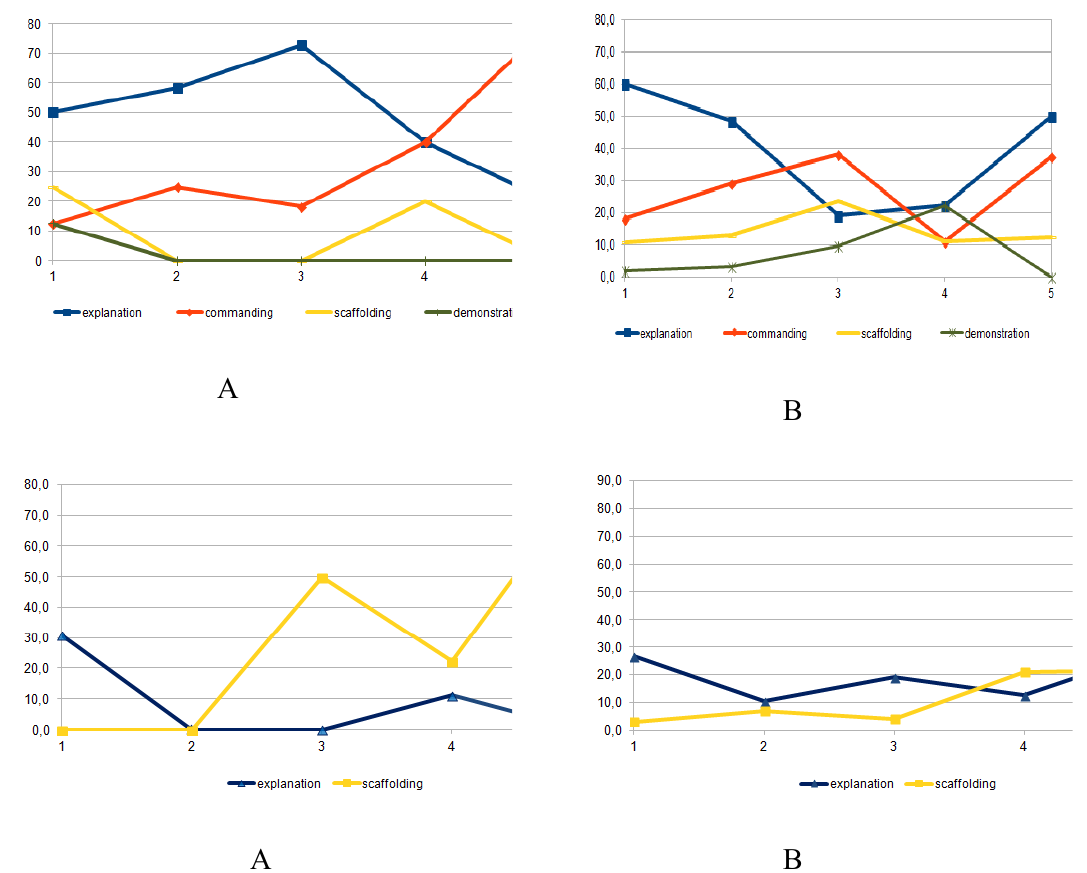
Figure 5. The most frequent techniques of tutors who were users of the given website and had prepared (YY) (Figure A) or had not prepared for the session (YN) (Figure B) in